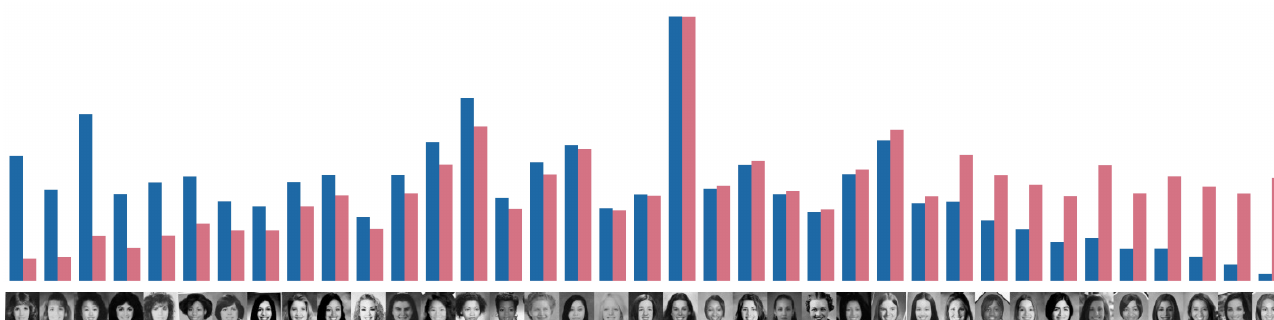
Figure 9. Summary of a dependent 0.1-MMD coreset for four datasets of yearbook faces from the 1990s and 2000s. Exemplars are shown along the x axis. The average weight for each exemplar in the coresets associated with the 1990s is shown in blue ; the average weight for the 2000s is shown in red .